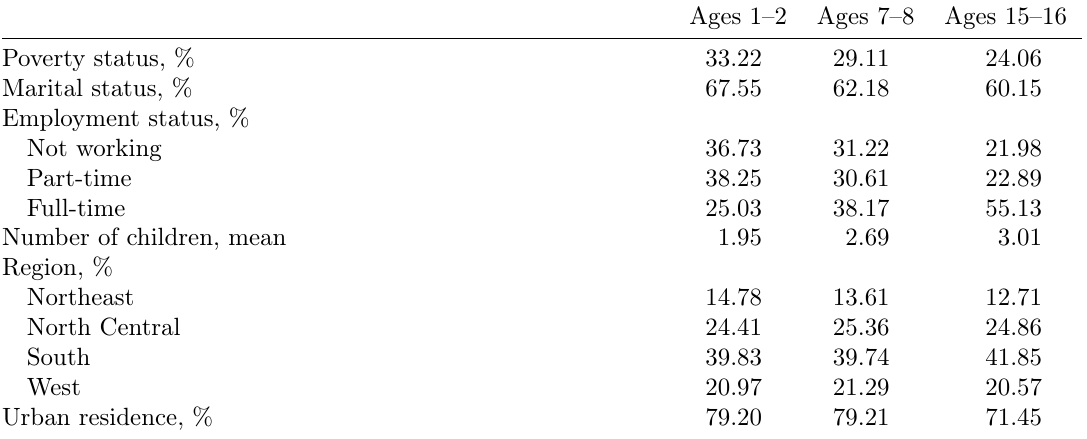
Table 2: Descriptive Statistics for Age-Varying Characteristics ( N = 3 , 744